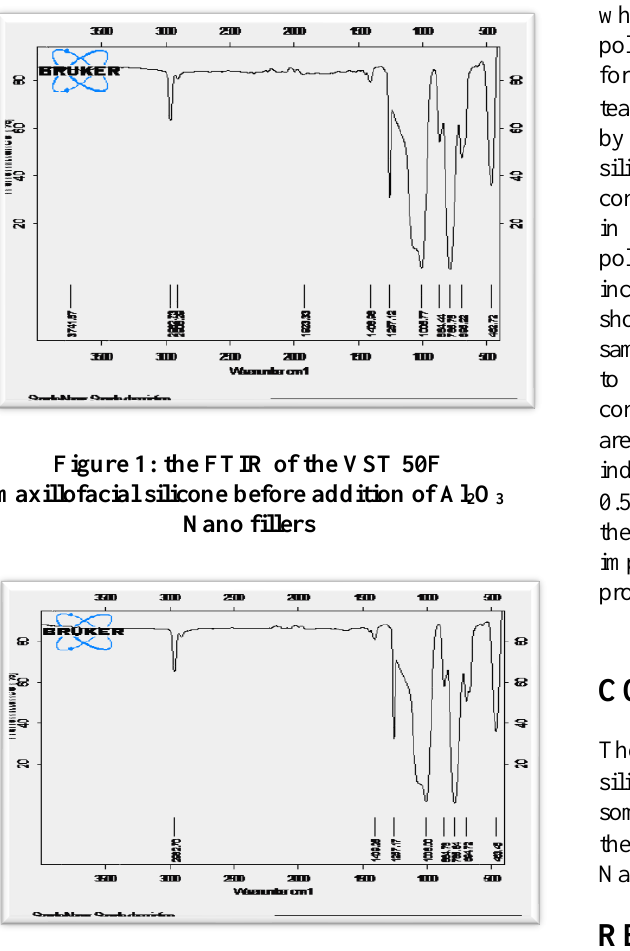
Figure 2: the FTIR of the VST 50F maxillofacial silicone after addition of Al 2 O 3 Nano